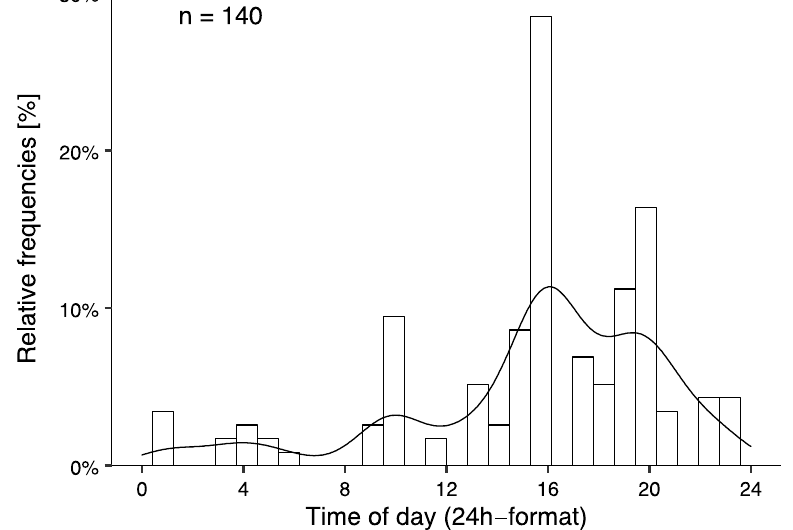
Figure 3. Histograms illustrating the time of the